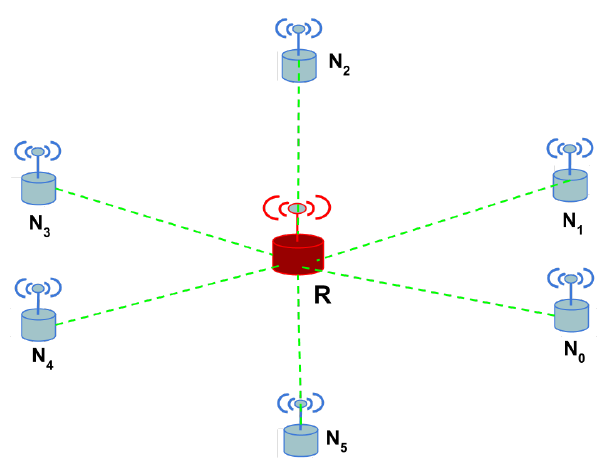
Figure 8. Network topology used for the